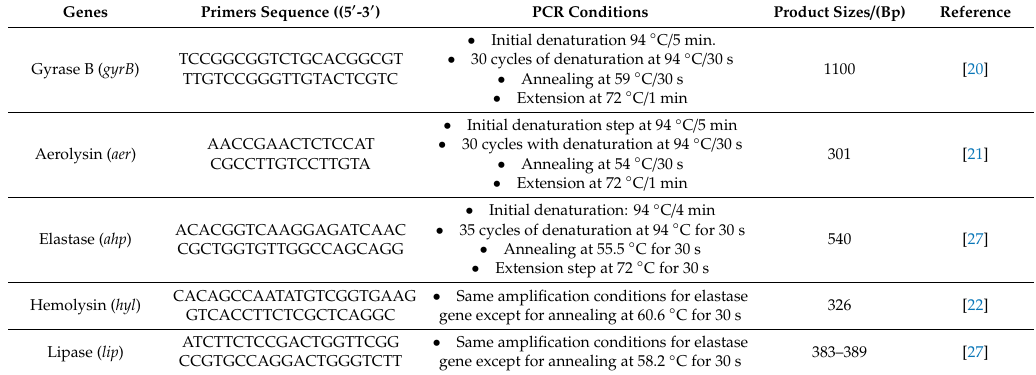
Table 2. The primer sets, PCR conditions, and size of the amplified sequence of Aeromonas isolates. Genes Primers Sequence ((5 (cid:48) -3 (cid:48) ) PCR Conditions Product Sizes / (Bp)